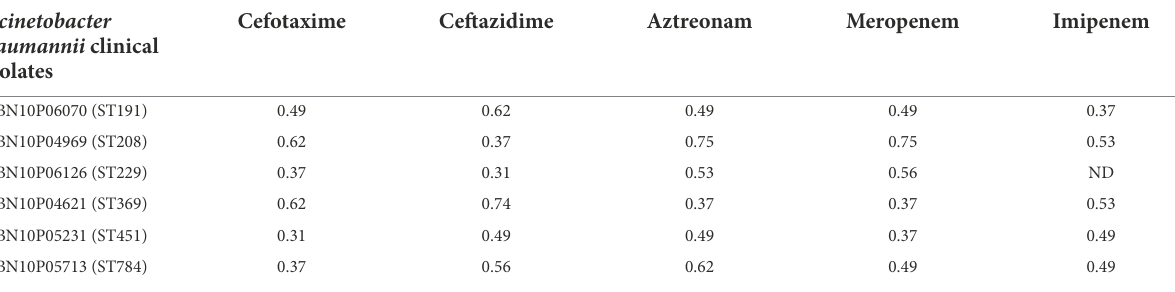
TABLE 1 Fractional inhibitory concentration index (FICI) of eAbEndolysin with various antibiotics. Acinetobacter baumannii clinical